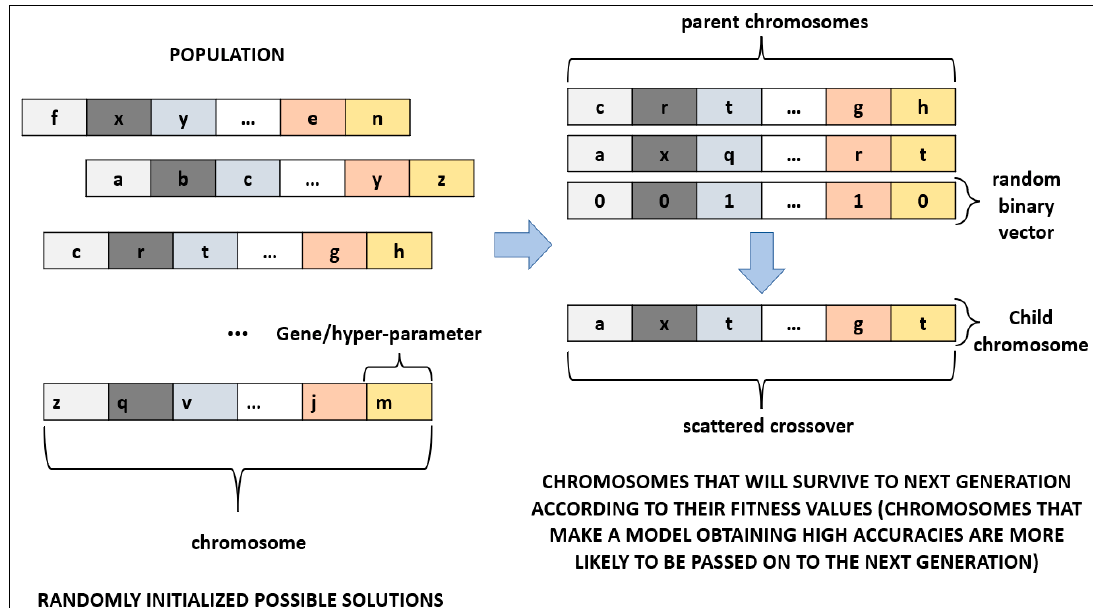
Figure 4. Process of scattered crossover in GA. (Illustrations by the authors). For 1-D CNN DL, hyper-parameters, such as filter size and number of filters, were architecture is shown in Figure